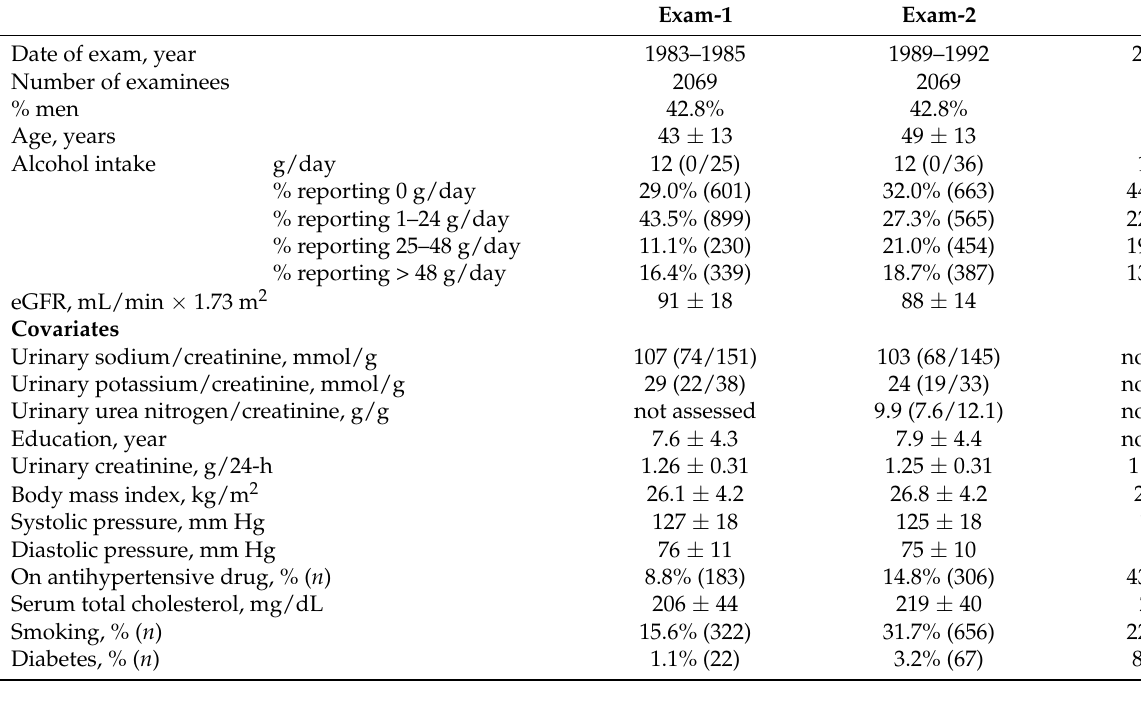
Table 1. Descriptive statistics in examinees with complete data at Exam-1, Exam-2, and Exam-3: prevalence for categorical variable, mean ± SD for non-skewed variables, and median (IQR) for skewed variables.